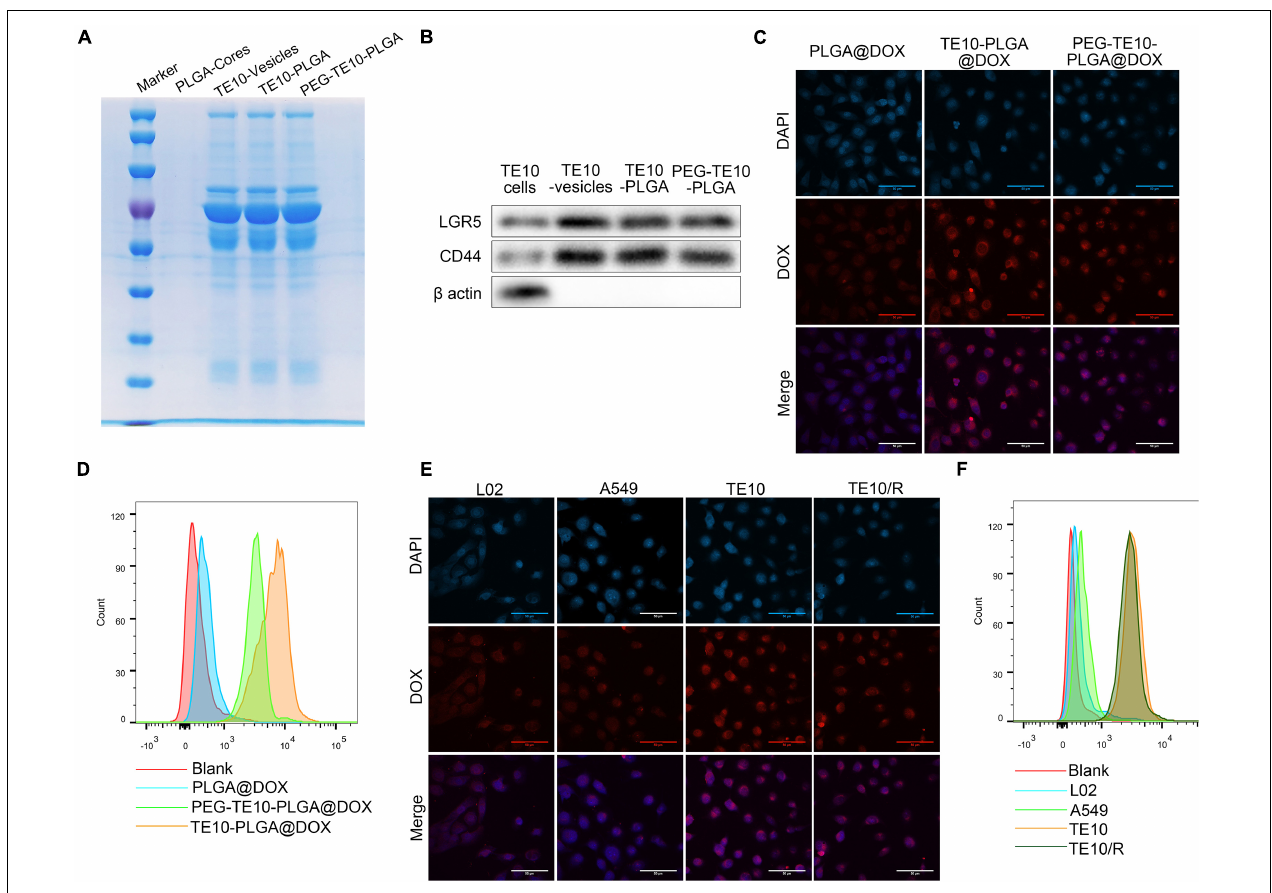
FIGURE 2 | Specific uptake of PMPNs by homologous tumor cells. (A) SDS-PAGE analysis of PLGA-Cores, TE10-vesicles, TE10-PLGA and PEG-TE10-PLGA. (B) Western blot analysis of biomarkers of TE10 cell membrane on PLGA-Cores, TE10-vesicles, TE10-PLGA and PEG-TE10-PLGA. (C,D) Evaluating the uptake of PLGA@DOX, TE10-PLGA@DOX, and PEG-TE10-PLGA@DOX into TE10 cells by laser confocal microscopy (C) and flow cytometry (D) . (E,F) L02, A549 and TE10/DOX cells were used to evaluate the tumor targeting capacity of PEG-TE10-PLGA@DOX by laser confocal microscopy (E) and flow cytometry (F)